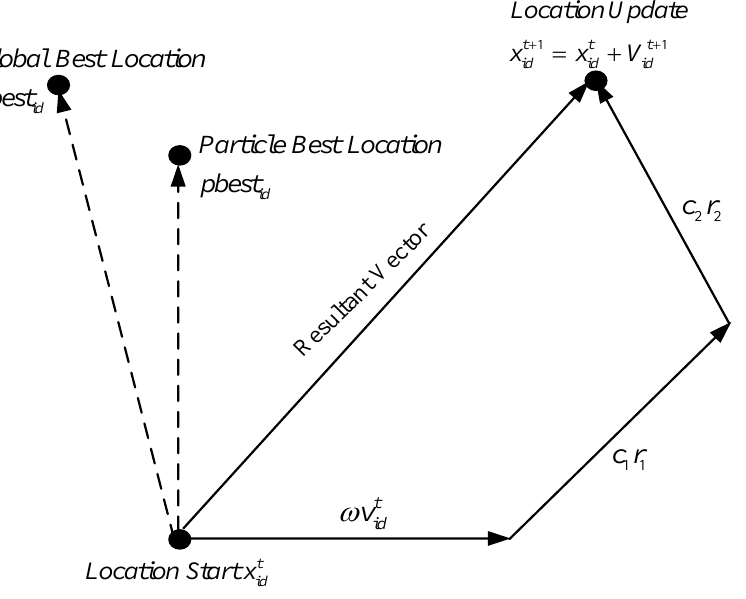
Figure 4. PSO’s pictorial description.